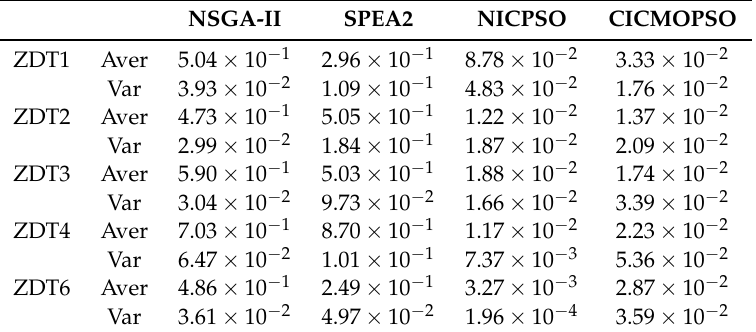
Table 5. Comparison of results for the Spacing index(S).